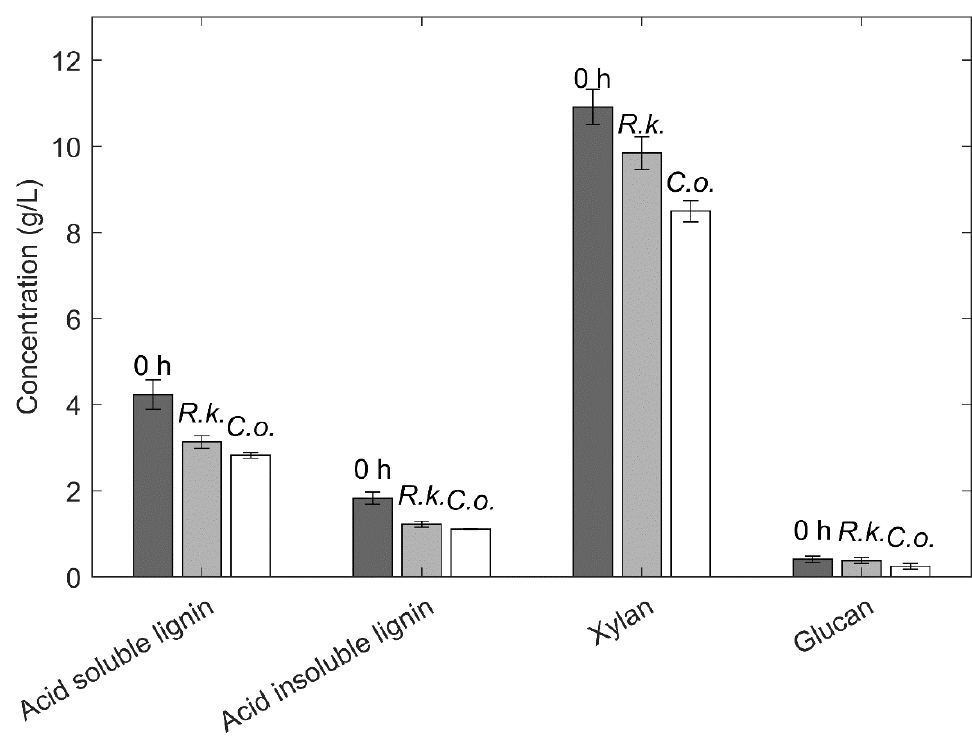
Figure 5. Concentrations of the non-monomeric substrates, i.e., acid-soluble lignin, acid-insoluble lignin, xylan, and glucan ( ■ ) before fermentation and ( ■ ) at the end of the first cycle for R. kratochvilovae ( R.k. ) and (□) C. oleaginosum ( C.o. ). Due to the presence of phenolics and furans in the waste stream, the acid-soluble lignin was overestimated. The concentrations are the average of three analytical repeats, and the error bars present the standard deviation.